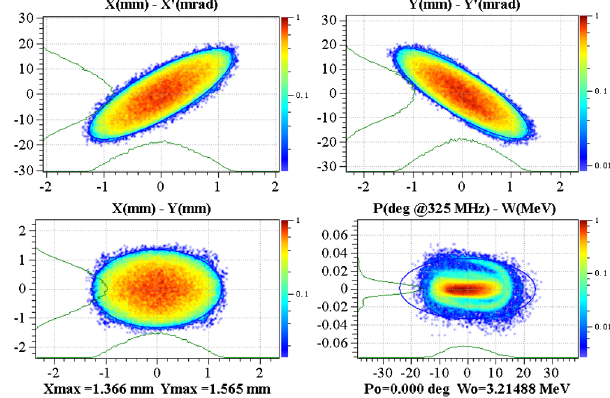
MEBT.FIG. 5. The RFQ simulated output phase space exit